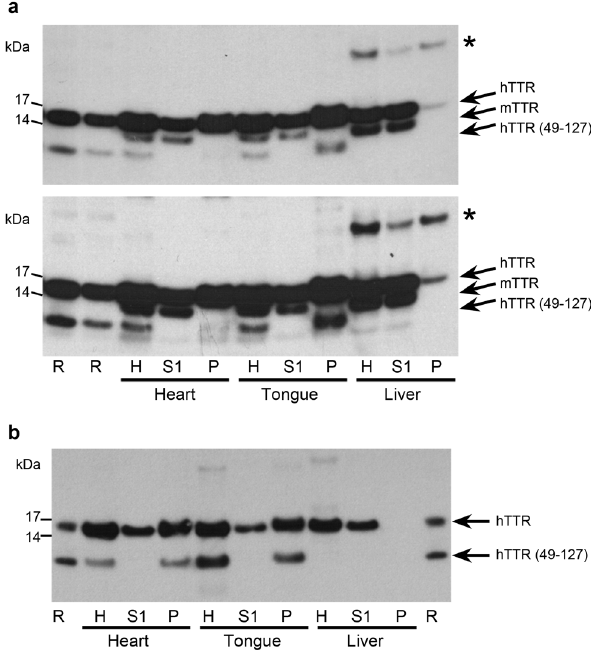
Fig. 4 Presence of cleaved human TTR in transgenic human ATTR amyloid. Homogenates of heart, tongue and liver from amyloidotic line O5 and line N4 mice ( a and b , respectively) were fractionated into soluble and insoluble fractions, and analysed by western blotting. Lanes labelled H contain unfractionated homogenates, lanes labelled S1 contained the soluble fraction ( fi rst supernatant), and lanes labelled P contained the insoluble fraction (pellet). The line O5 mouse ( a ) was homozygous wild- type for mouse ttr and the line N4 mouse ( b ) was homozygous for the mouse ttr knockout allele. The same proportion of the entire sample was loaded in each lane; two exposures are shown in a to reveal all relevant bands. Data are representative of n = 5 ( a ) and n = 2 ( b ) biological replicates. Lanes labelled R contained recombinant human TTR S52P that had undergone limited tryptic cleavage; the positions of full-length TTR protomer, the 49 – 127 cleavage product and mouse TTR are indicated. Glycosylated human TTR protomer is indicated by asterisks. Source data are provided as a Source Data fi